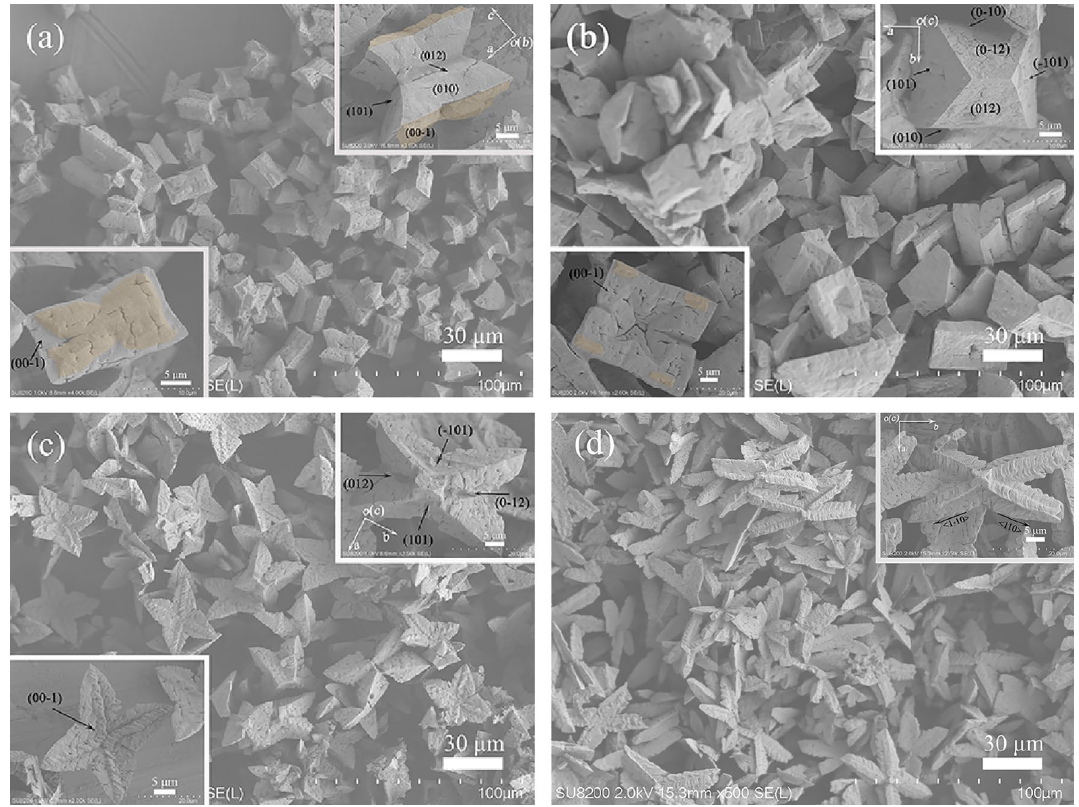
Figure 6. Representative FESEM images of the samples biomimetically synthesized for 60 ( a ), 90 ( b ), 130 ( c ), or 180 min ( d ) with the